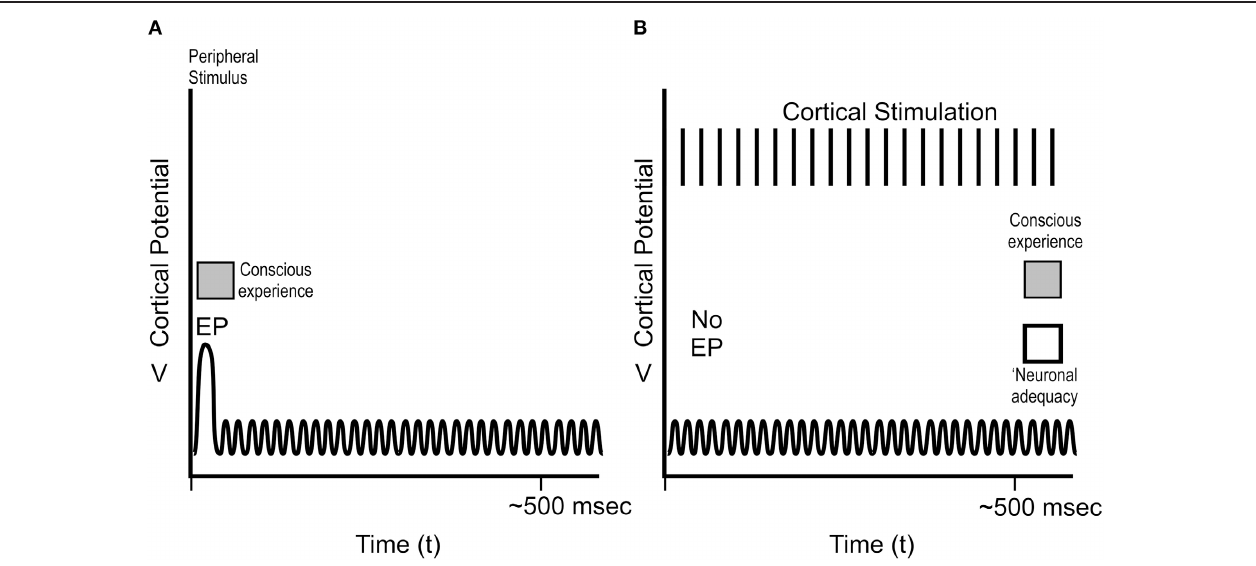
activity of the somatosensory cortical hand area for several 100ms results in no EP, ongoing cortical activity, and conscious sensory experience of the hand, but only after ∼ 500ms. Libet termed the 500ms of cortical activity resulting in conscious experience “neuronal adequacy.”